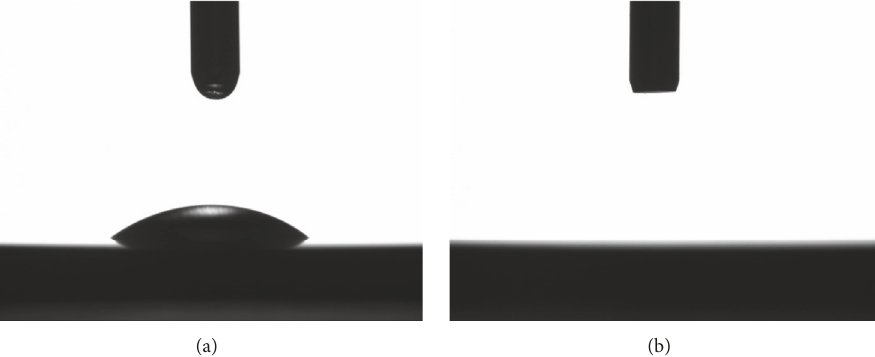
Figure 3: Contact angles of specimens before and after pretreatment: (a) sandpaper polished; (b) acid etched